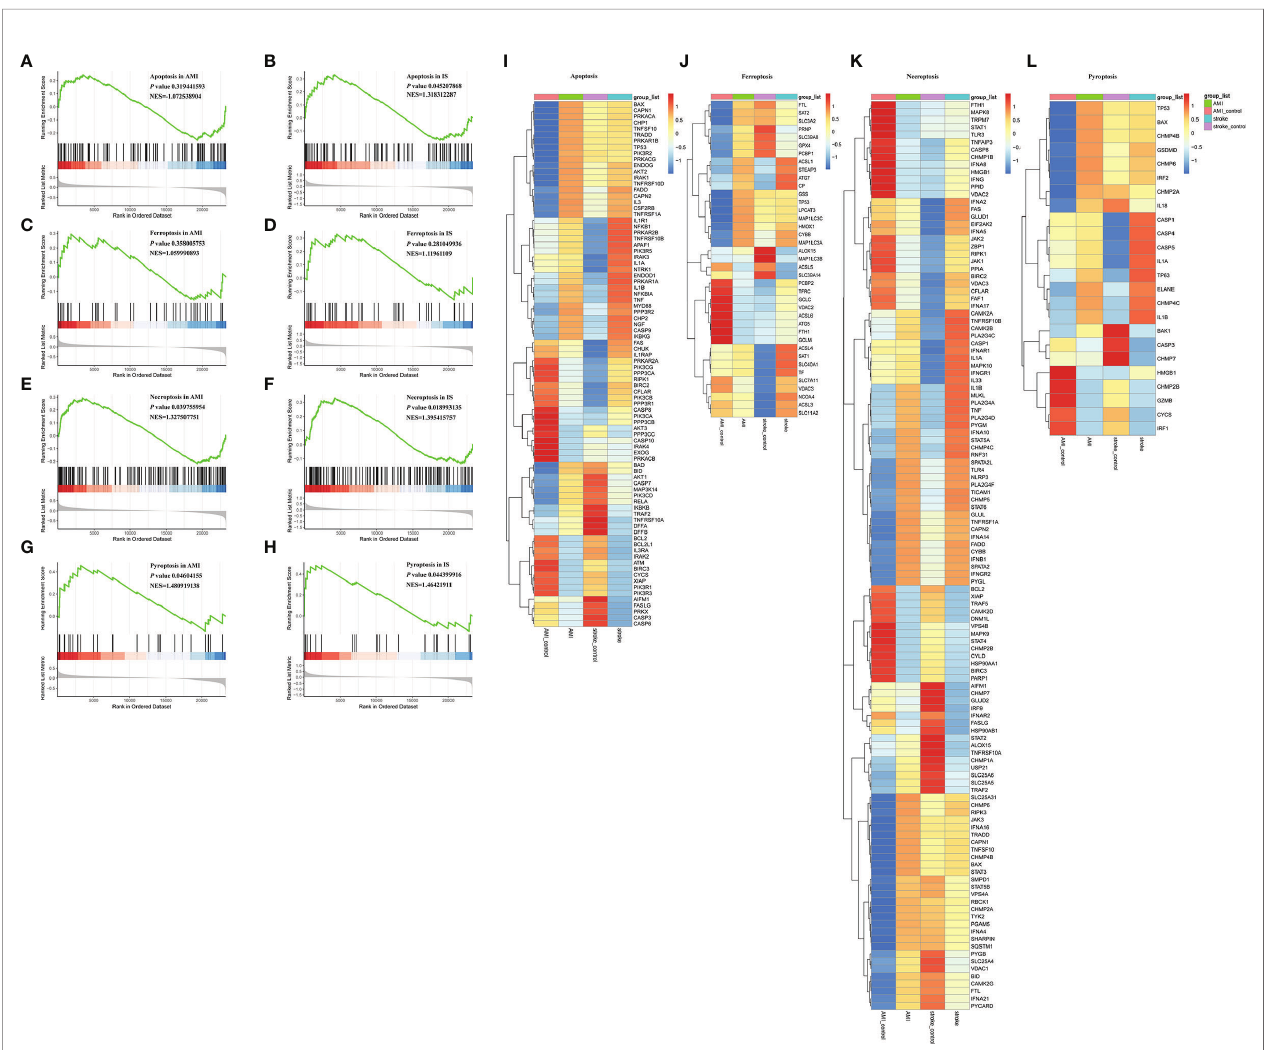
FIGURE 5 | GSEA of apoptosis, necroptosis, ferroptosis, and pyroptosis. (A) GSEA of apoptosis in AMI. (B) GSEA of apoptosis in IS. (C) GSEA of ferroptosis in AMI. (D) GSEA of ferroptosis in IS. (E) GSEA of necroptosis in AMI. (F) GSEA of necroptosis in IS. (G) GSEA of pyroptosis in AMI. (H) GSEA of pyroptosis in IS. Statistically signi fi cant associations were determined by permutation test. (I) Heatmaps of DEGs in apoptosis. (J) Heatmaps of DEGs in necroptosis. (K) Heatmaps of DEGs in ferroptosis. (L) Heatmaps of DEGs in